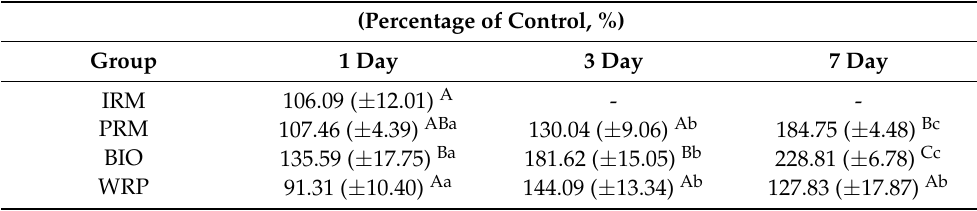
Table 3. Cell viability in ULA groups.